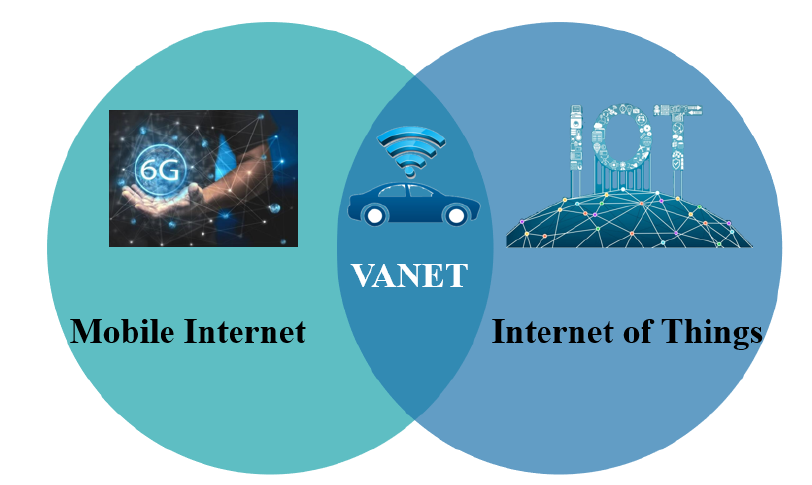
Figure 1. The relationship between the VANET and the